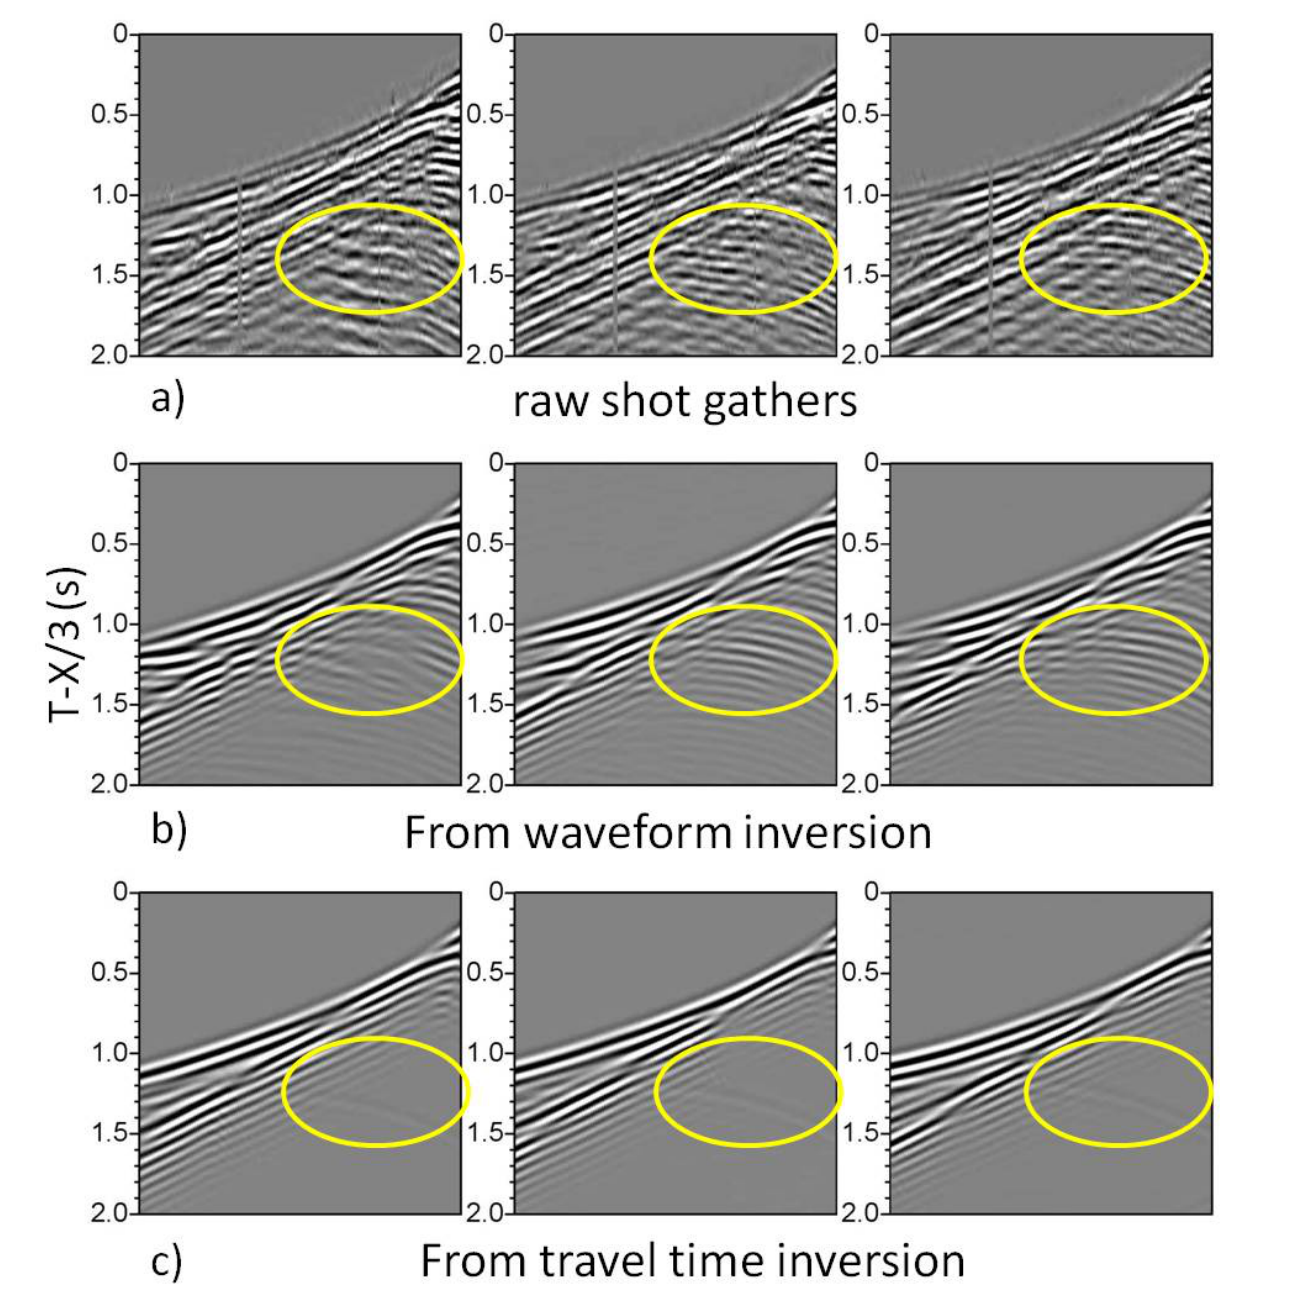
Figure 12. Shot gathers through the low velocity zone at model distance 6 km, 8 km, 10 km. ( a ) Observed shot gathers, ( b ) synthetic shot gathers using full waveform inversion (FWI) velocity model, and ( c ) synthetic shot gathers using travel time velocity